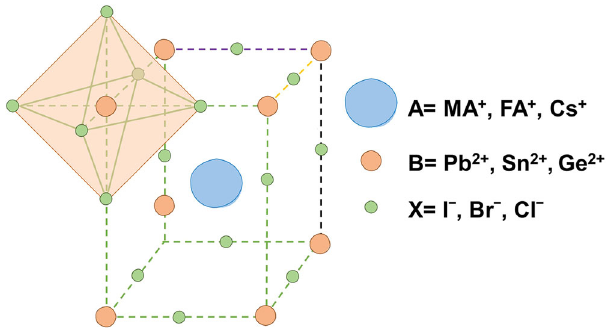
Fig. 1 Scheme of the crystalline structure of 3D perovskite. A depicts monovalent organic or inorganic cations, B represents divalent cations, and X represents halide anions. (Fig. 1 reprinted with permission 135